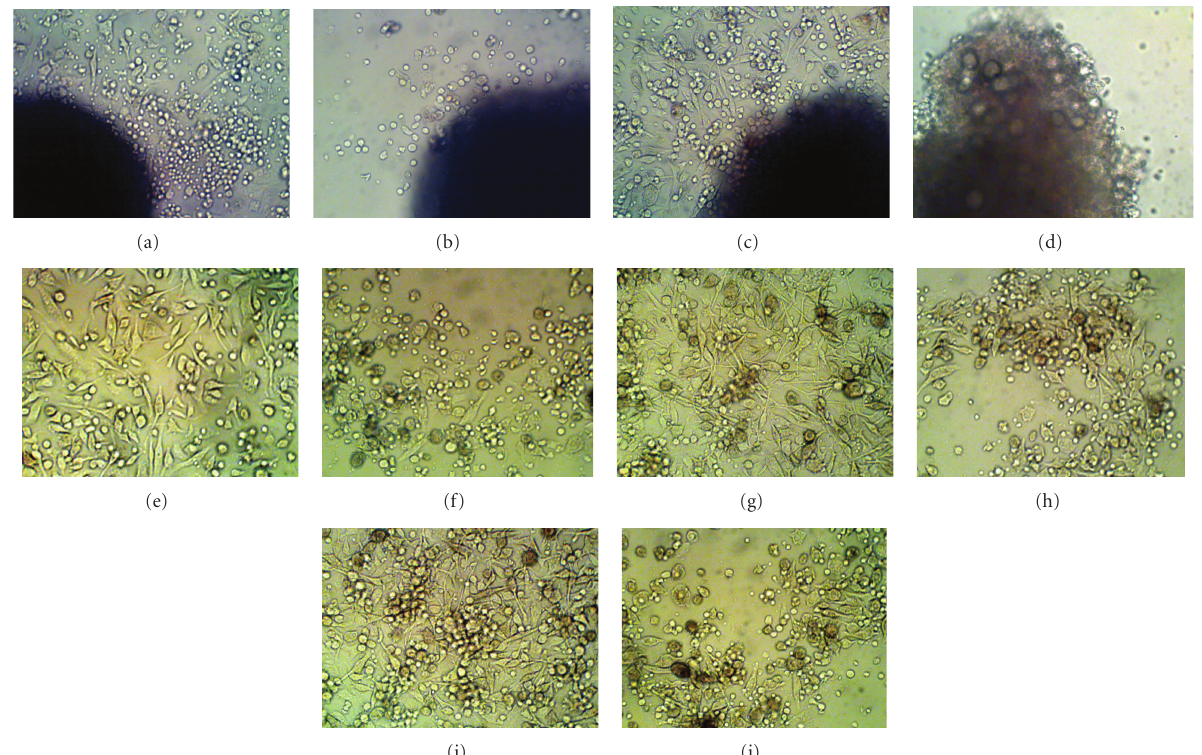
Figure 1: (a) The explant from the normal bone marrow showed healthy cell generation at day 3 of culture. (b) Explant from the aplastic bone marrow showed stunted cellular growth with little or no cellular generation at day 3 of culture. (c) At day 7 of culture, explant from the normal bone marrow demonstrated a cumulative cell production with the e ffi cacy of stromal matrix formation which was completely absent in the explant from aplastic marrow (d). (e) After 11 days of culture, the cells released from the normal bone marrow created various stromal microenvironments like structures throughout the culture dish distal from the explant compared to the aplastic bone marrow where no such stromal matrix generation was observed with predominant appearance of immature stromal precursors and stromal fibroblasts (f). (g) After day 16 of culture, the cells from the normal bone marrow produced a coordinated network of mature stromal matrix of fibroblastic cells upon which small hematopoietic cellular colony formation can be noticed. (h) After 16 days of the culture, the cells from the aplastic bone marrow failed to generate a functional stromal matrix that can sustain hematopoiesis with abundance of immature giant stromal precursors and fibroblastic cells. (i) After 19 days of culture, the normal marrow generated stromal matrix was appeared to be even more organized with appearance of large hematopoietic colonies associated with it, compared to the aplastic marrow where no such functional stromal matrix formation with associated cellular colony generation was observed